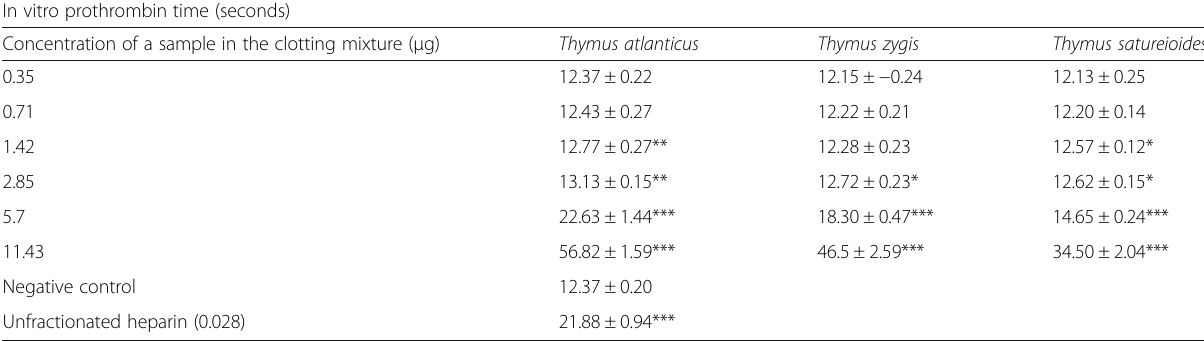
Table 4 In vitro prothrombin time measurements of aqueous extract in human pooled plasma In vitro prothrombin time (seconds) Concentration of a sample in the clotting mixture ( μ g)